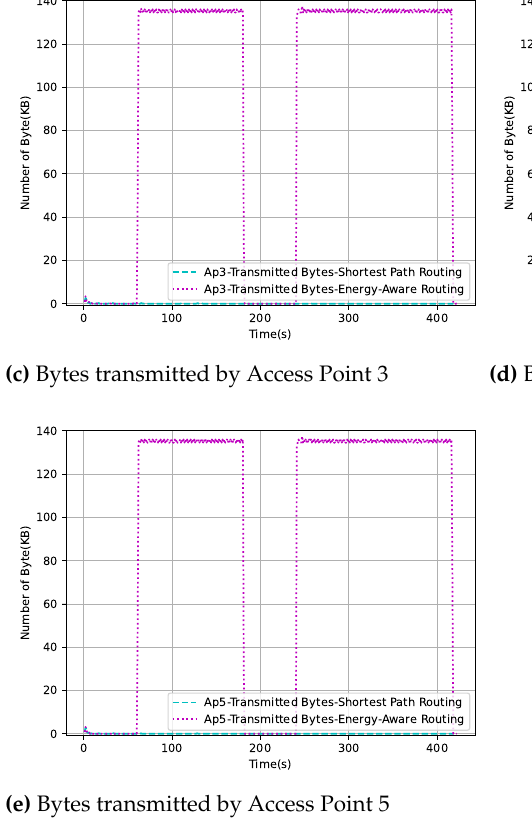
Figure 7. Bytes transmitted by access